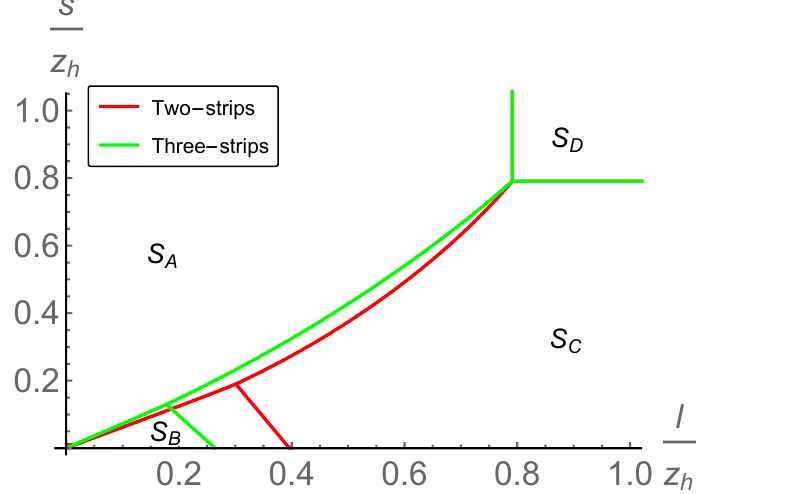
Figure 3 . Phase diagram for the bipartite and tripartite configuration in the AdS soliton back- ground in d = 3